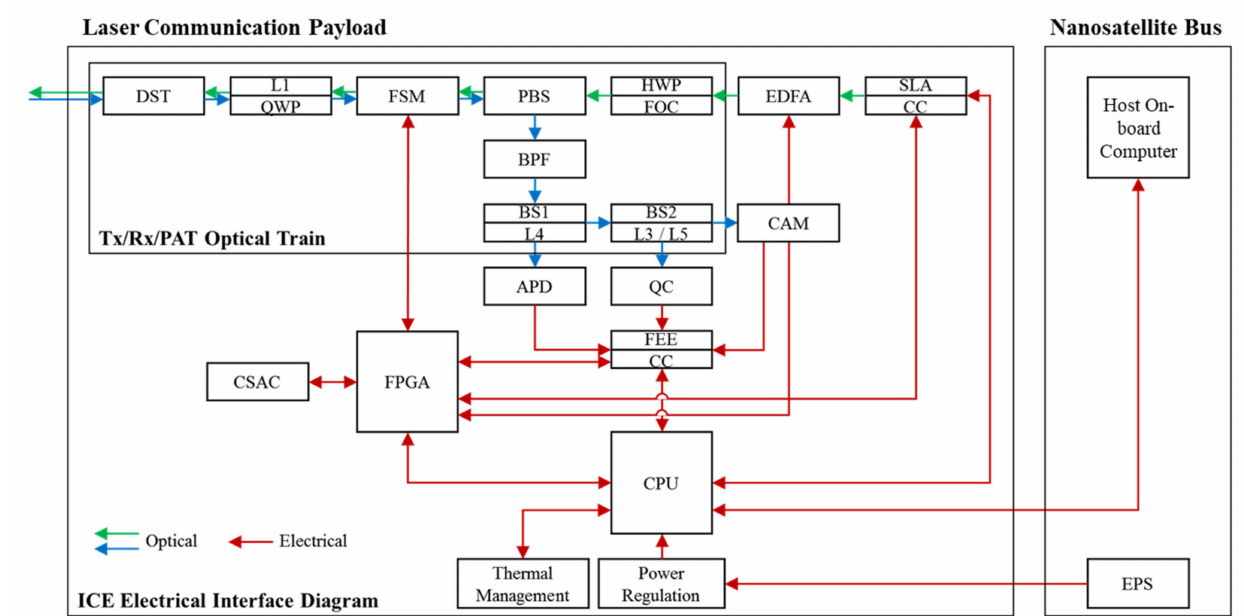
Figure 12. Diagram of optical path and electrical interface for the laser communication payload.